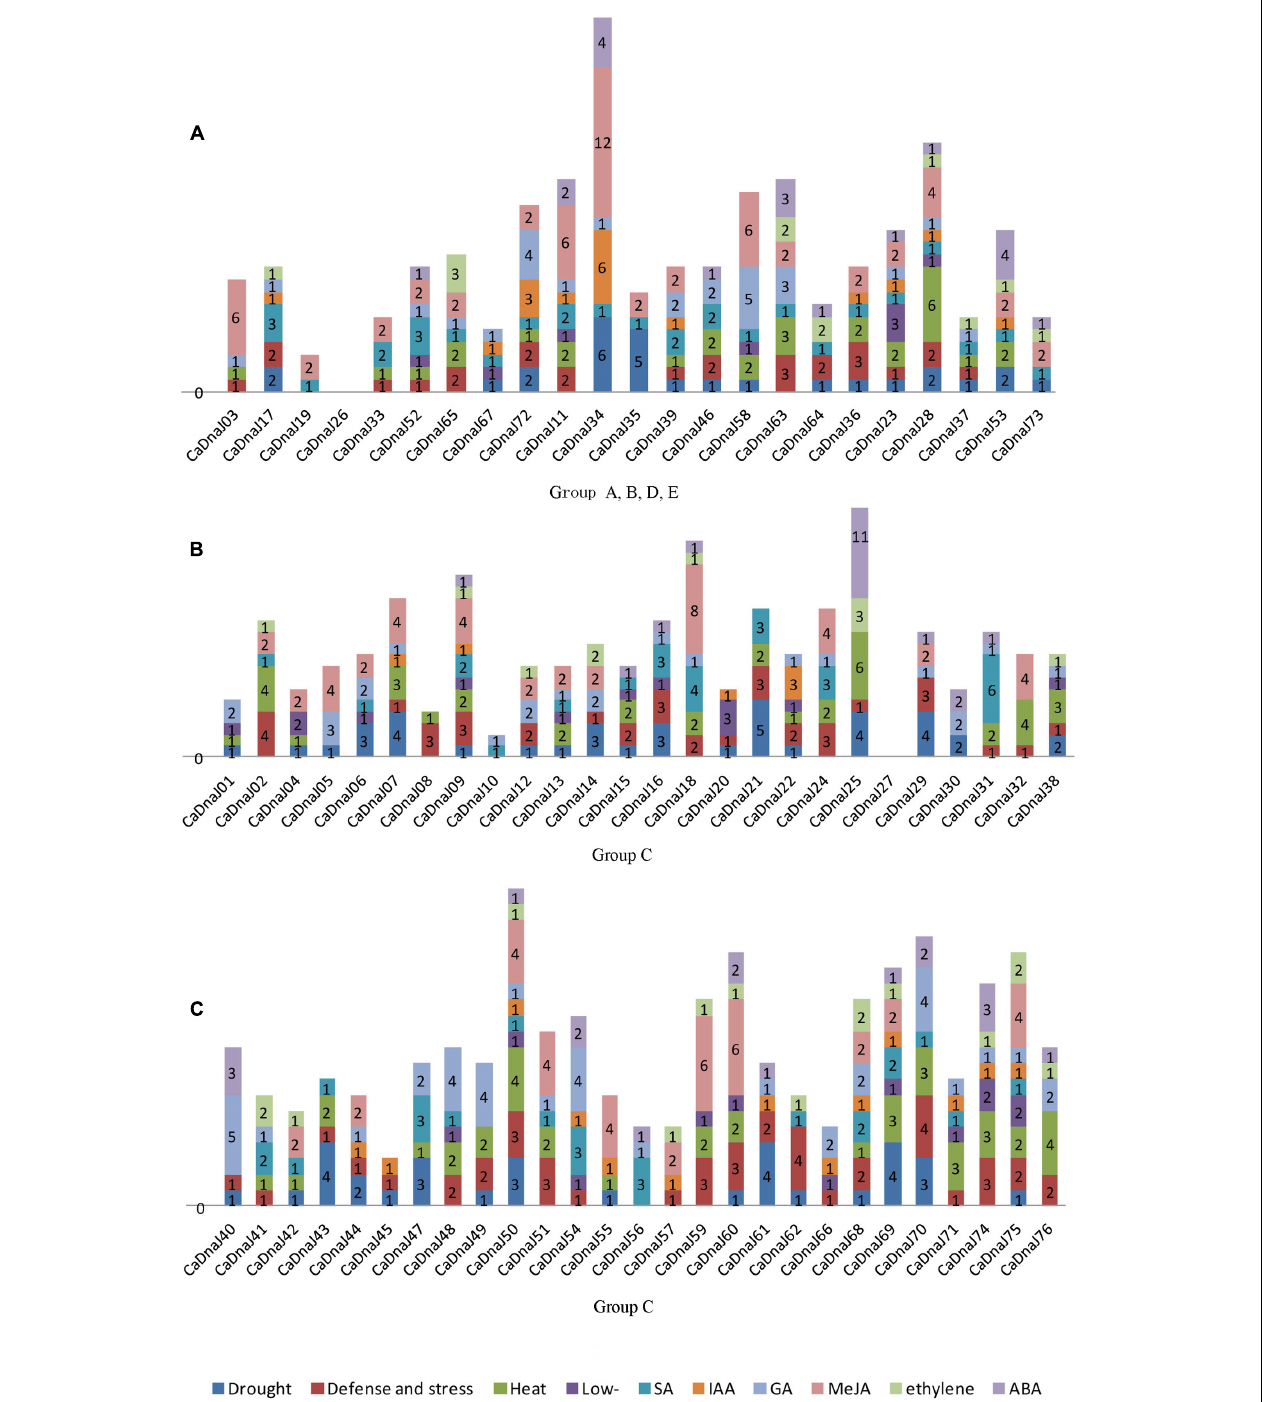
FIGURE 2 | Predicted cis -elements in the promoter regions of CaDnaJ genes. Promoter sequences (–1500 bp) for 74 CaDnaJ genes (promoter regions of CaDnaJ26 and 27 were absent) are analyzed. The names of the promoters of CaDnaJ genes are shown on the bottom of the figure. Different cis -elements with the common functions are marked with same color. (A) Predicted cis -elements in the promoter regions of group A, B, D, E. (B) Predicted cis -elements in the promoter regions of group C (26 of 53 CaDnaJs ). (C) Predicted cis -elements in the promoter regions of group C (27 of 53 CaDnaJs ).